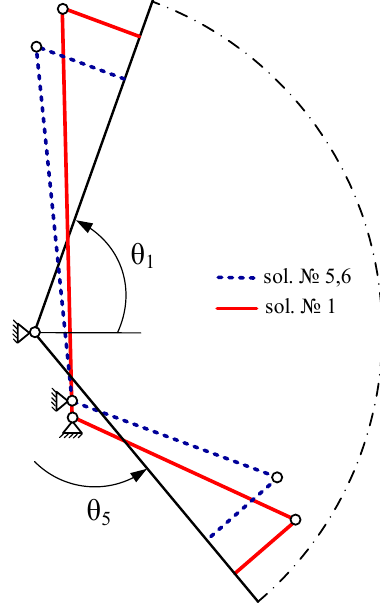
Figure 6. Scaled geometric layout of the attachment points for solutions № 1 and 5 from Table